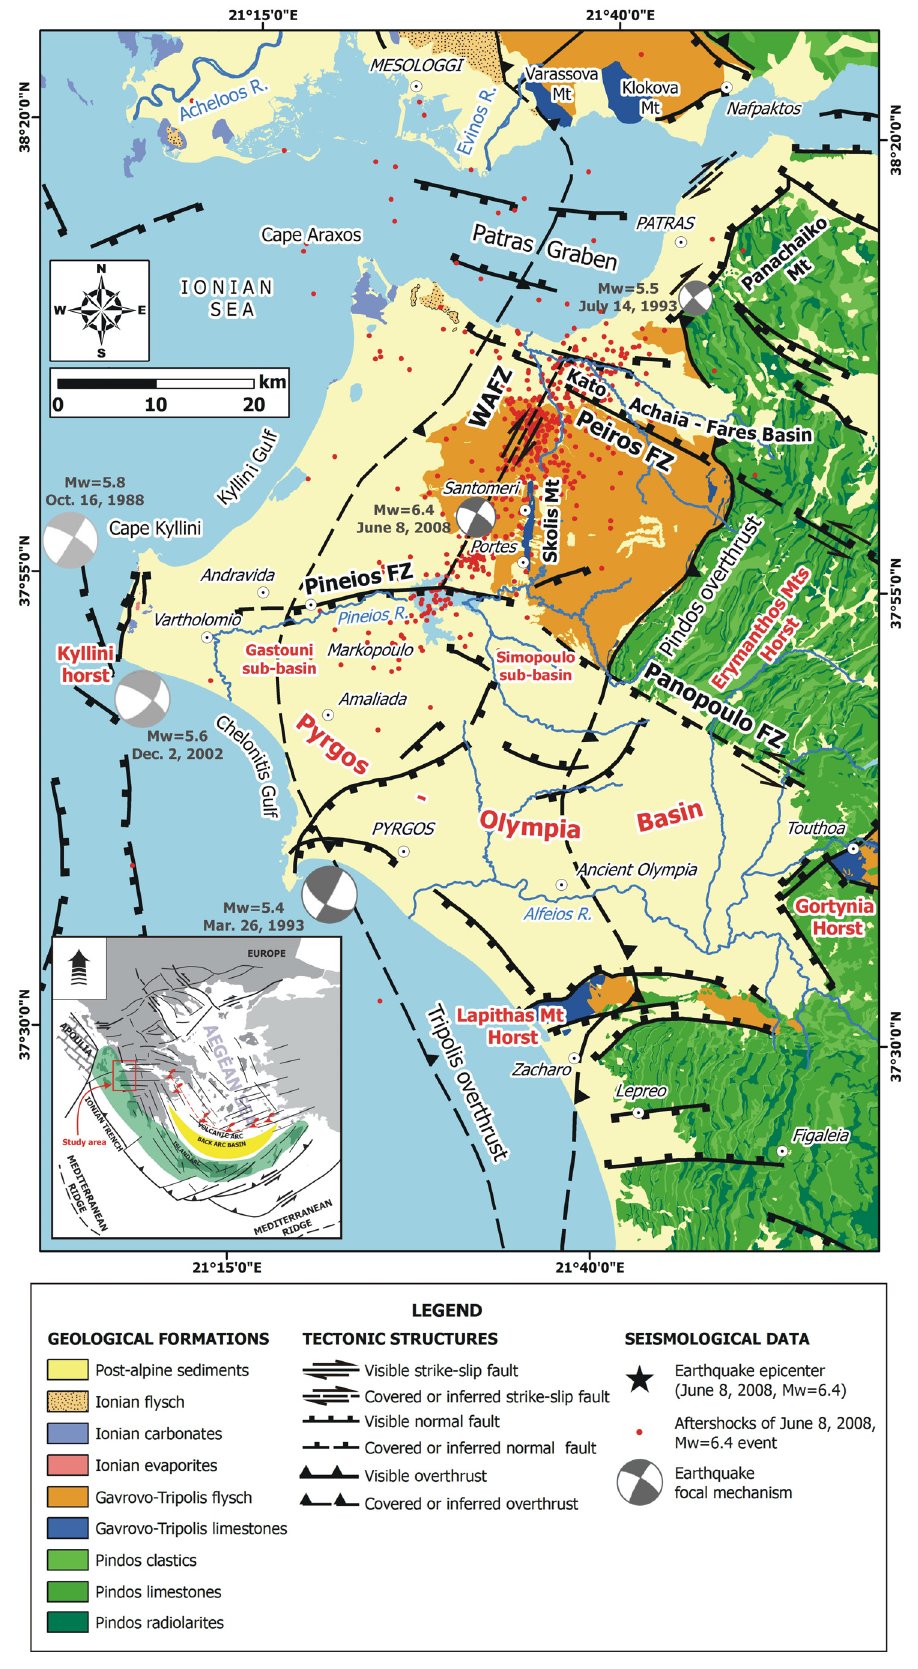
Figure 1. Geological map of the wider study area showing the major neotectonic macrostructures (Panachaiko Mt, Erymanthos Mts horst, Kato Achaia - Fares basin, Kyllini horst, Pyrgos - Olympia basin), the smaller neotectonic structures (Gastouni and Simopoulo sub-basins), the active fault zones based on Lekkas et al. [1992, 2000], Vassilakis et al. [2006], Mavroulis et al. [2010], Vassilakis et al. [2011] and Fountoulis et al. [2013] and the focal mechanisms of recent earthquakes in NW Peloponnese (1988 Kyllini, 1993 Patras, 1993 Pyrgos, 2002 Vartholomio, 2008 Andravida earthquakes) from Feng et al.